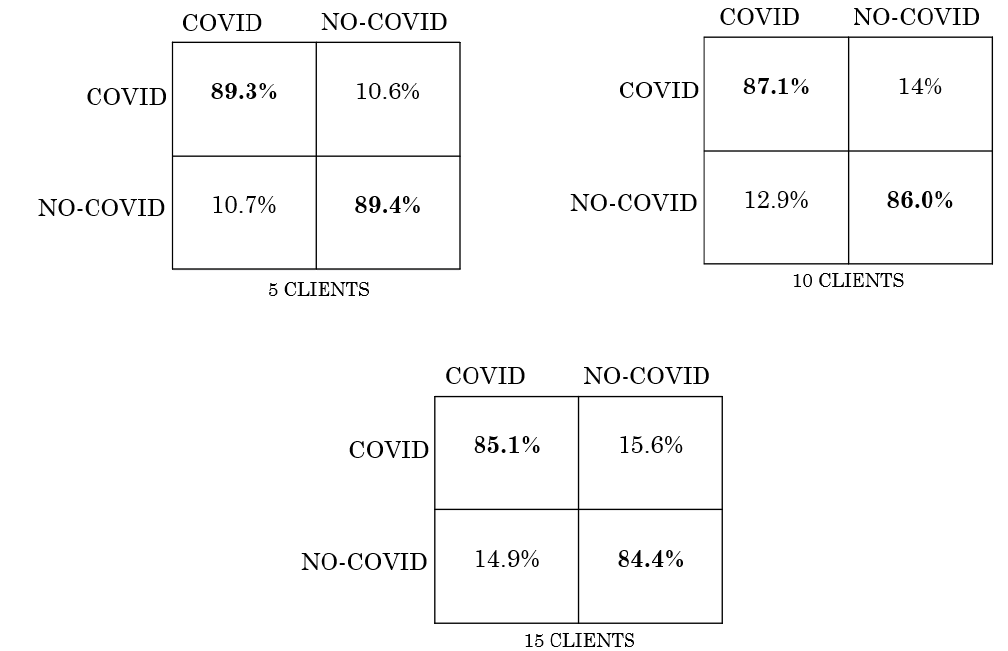
Figure 7. Confusion matrices for the NO-IID